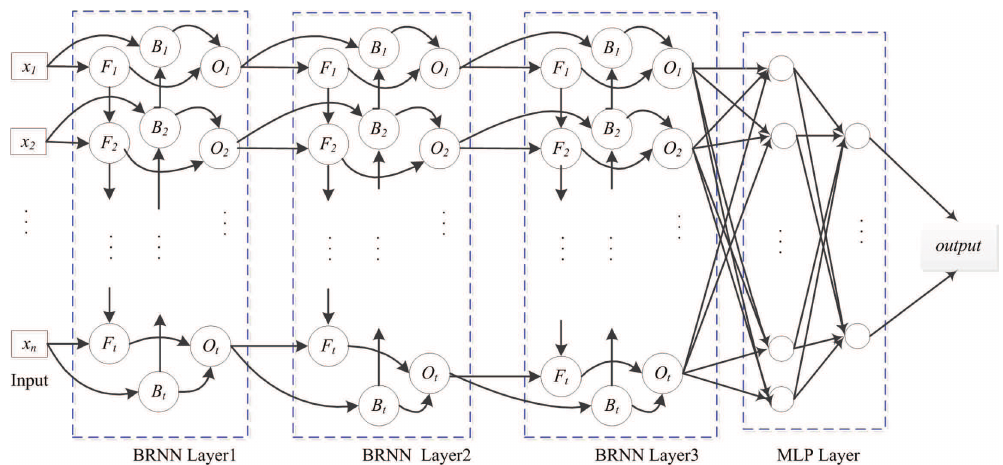
Figure 5. SDBRNN architecture. The merging operator “concat” is used in the first BRNN layer. The “sum” and “weighting sum” operator are used in the second and third layer. Two multi-perception networks are connected to